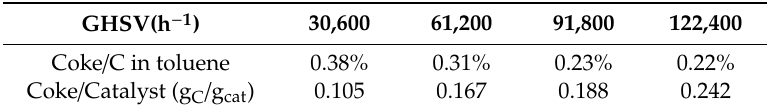
Table 4. Toluene conversion to coke deposited on the catalyst with di ff erent GHSV (S / C:3, 800 ◦ C, five-hour